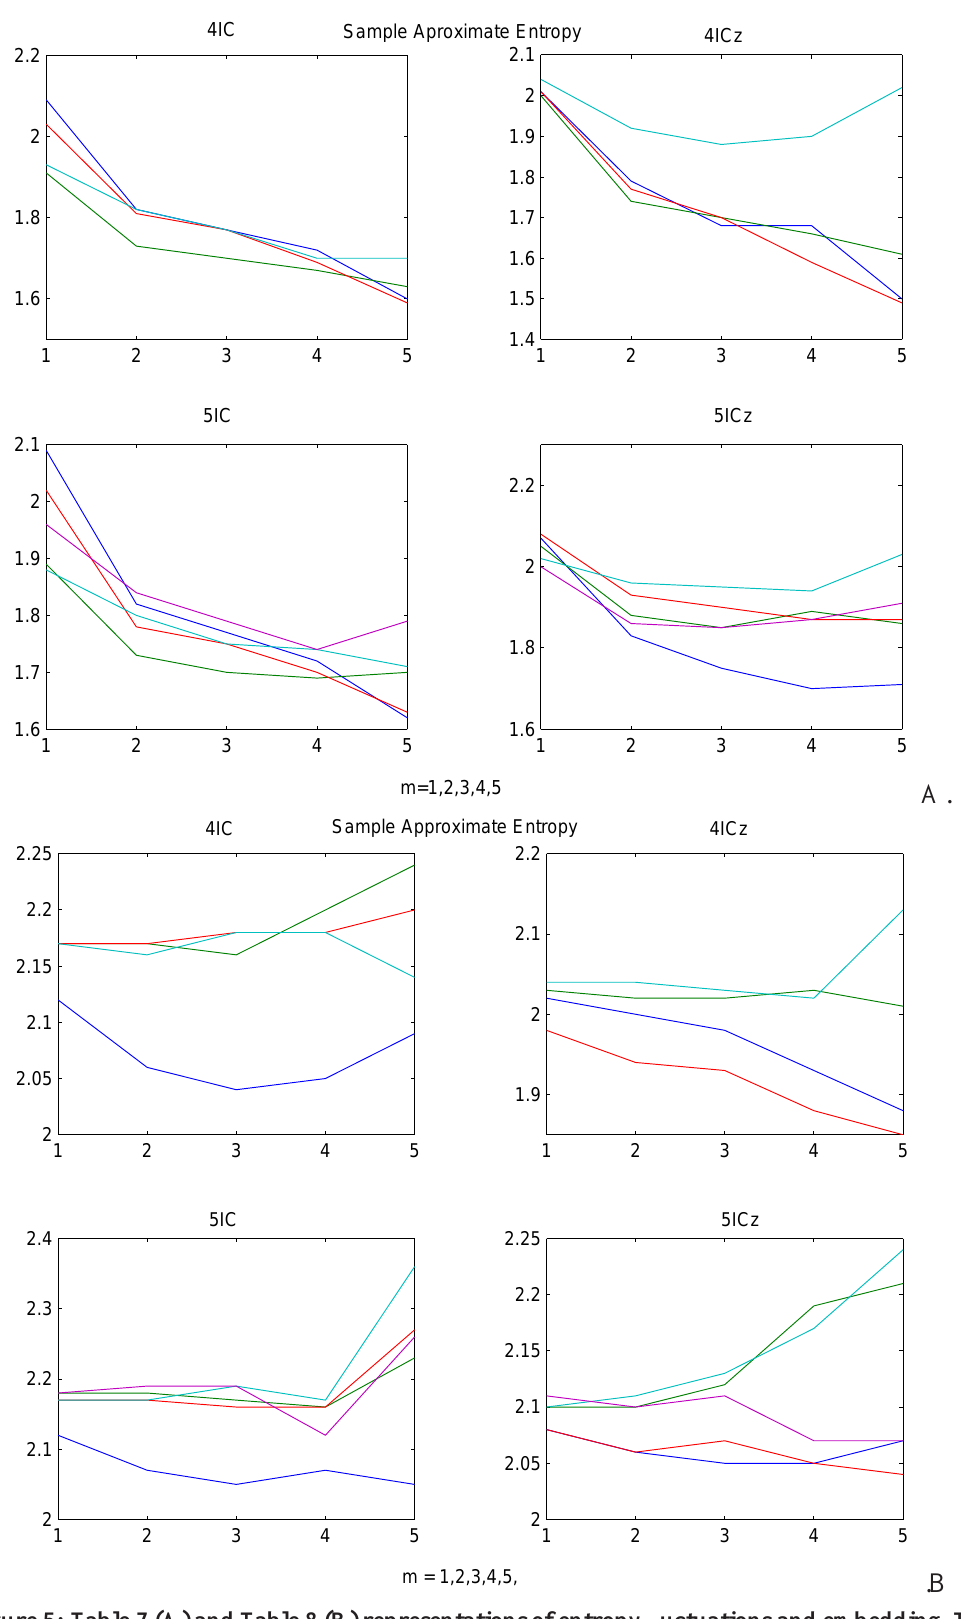
Figure 5: Table 7 (A) and Table 8 (B) representations of entropy fluctuations and embedding. The system in B is under